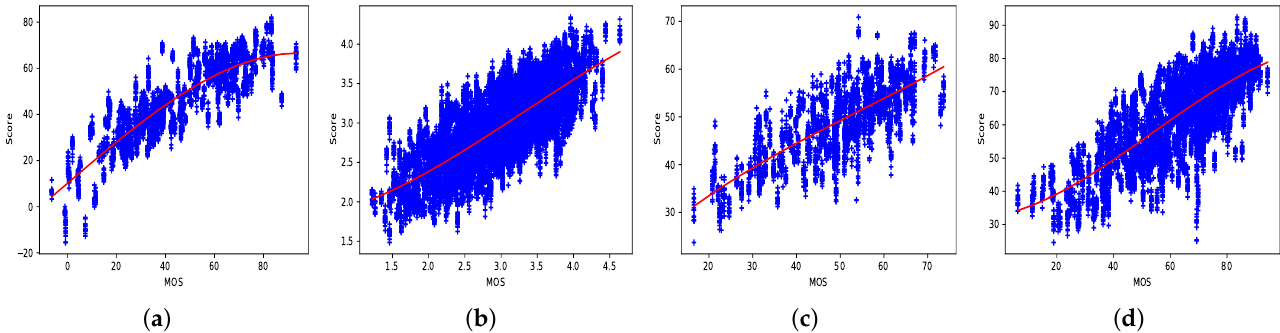
Figure 6. Scatter plots of the predicted scores versus MOS for the four considered databases: ( a ) CVD2014, ( b ) KonViD-1k, ( c ) LIVE-Qualcomm, and ( d )